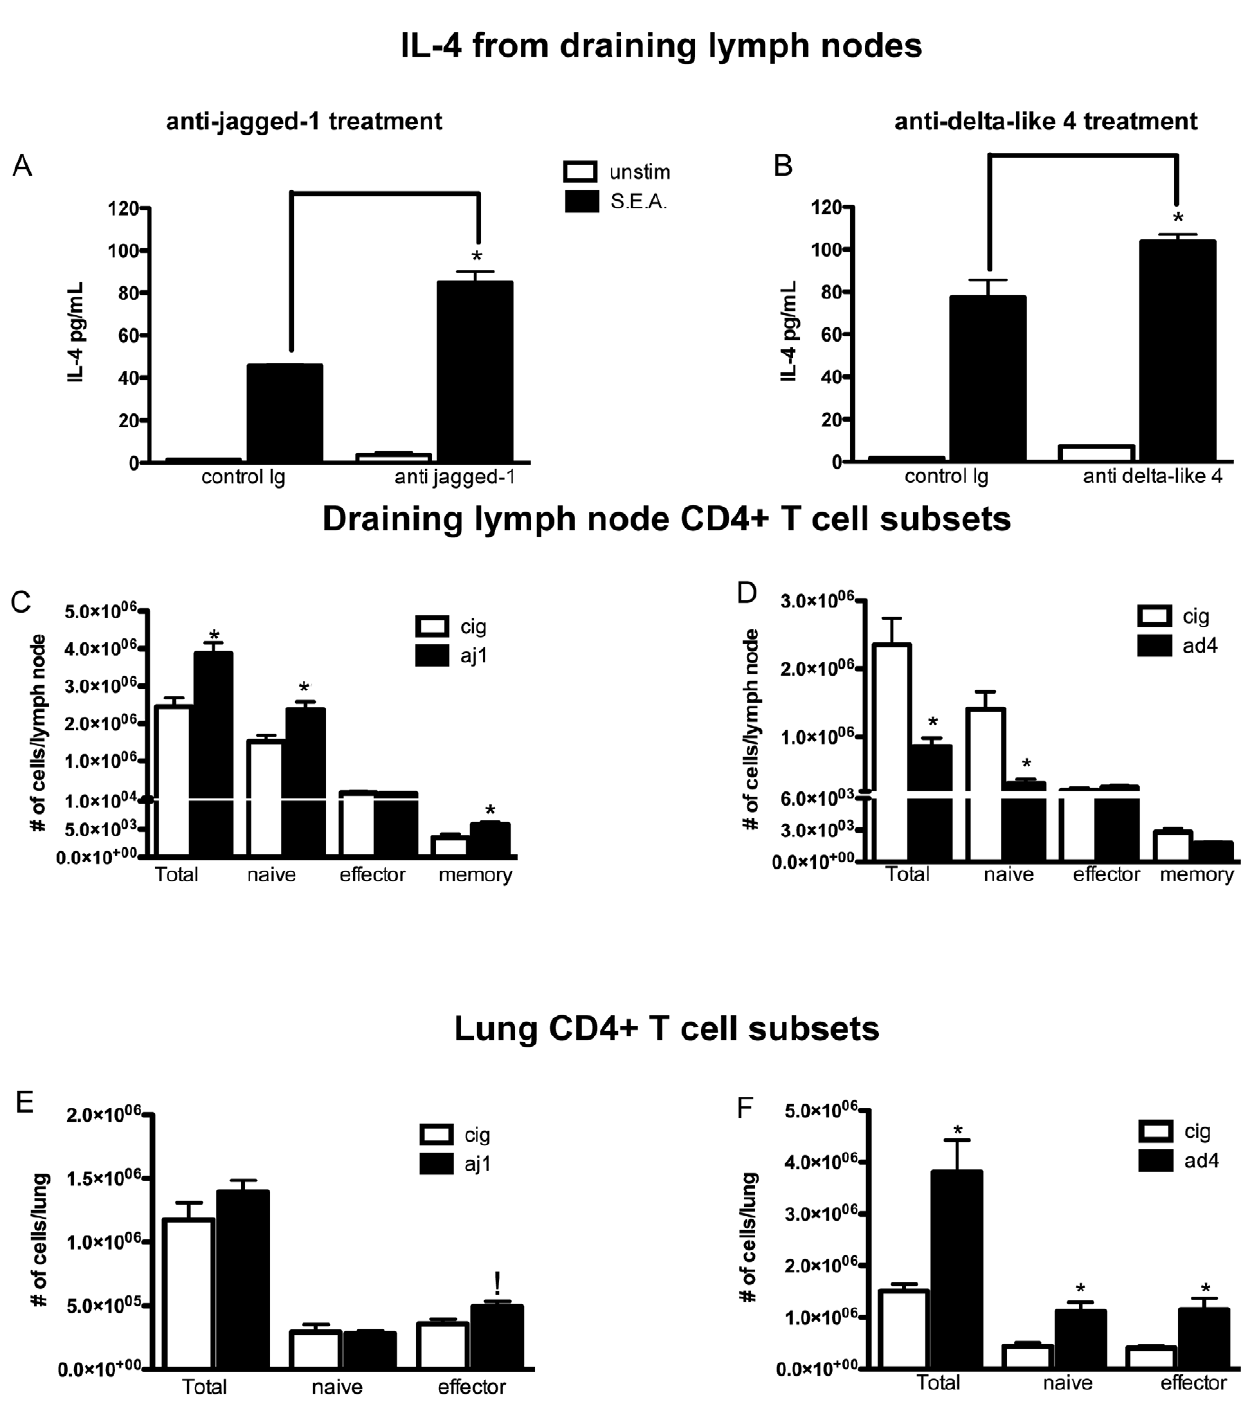
Figure 2. Anti jagged-1 andanti-delta-like 4 treatment altertheTh2 immune response. A,B)Lymphnodecells frommicetreated withanti-notch ligand antibodies produced significantly more IL-4when restimulated with SEA. *p # 0.01 using one-way ANOVA C–F) Changes inCD4 + T cell populations in the lung and lymph node during secondary S. mansoni immune response with anti-Notch ligand treatment. *p # 0.05 using unpaired T test.